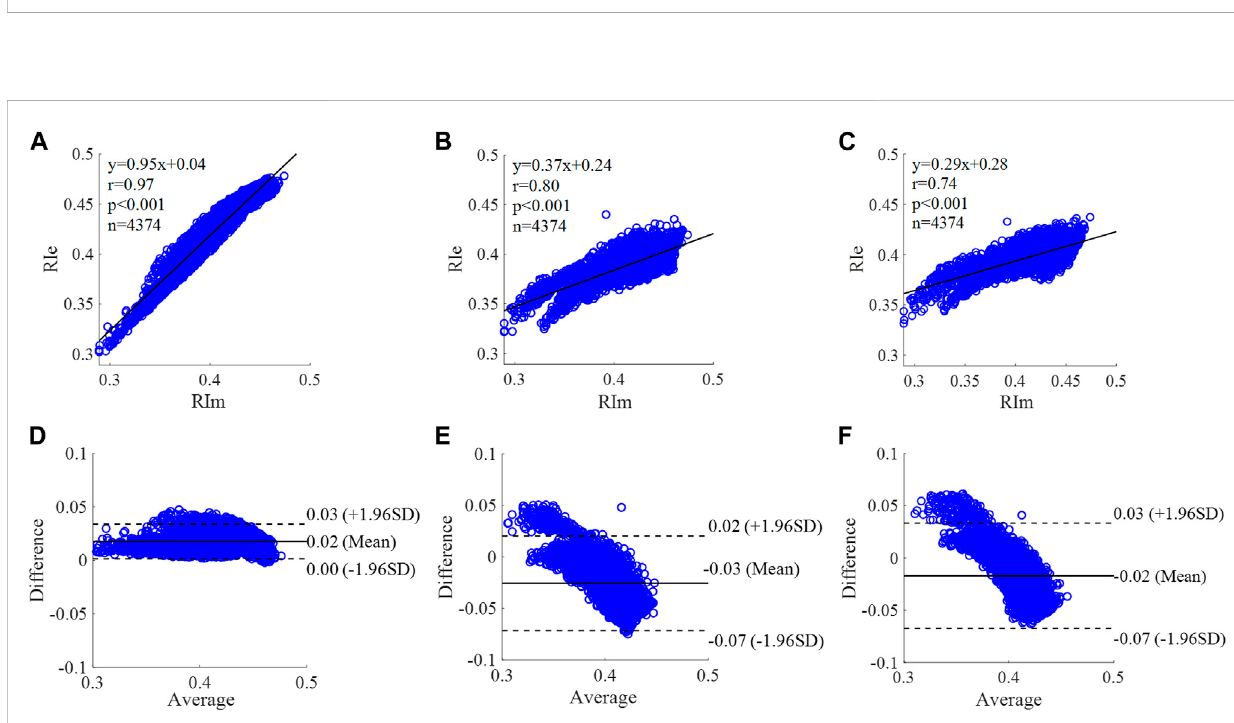
FIGURE 11 Correlation graphs and Bland-Altman plots of RM calculated by three fl ow waveforms (A) and (D) Results of the personalized fl ow wave (Clinical data, 13 participants); (B) and (E) Results of the triangular fl ow wave (Clinical data, 13 participants); (C) and (F) Results of the lognormal fl ow wave (Clinical data, 13 participants). RMm and RMe are measured and estimated RM, respectively. Difference: RMe - RMm; Average: (RMe + RMm)/2.